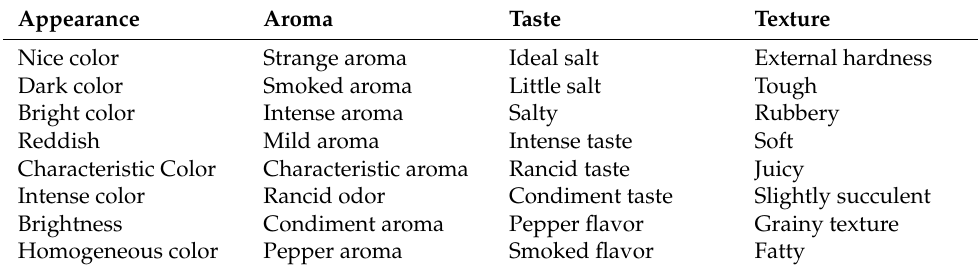
Table 2. Attributes selected to compile the CATA test list applied to hot dogs with sodium reduction and that had been